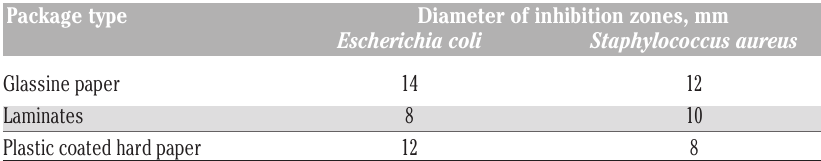
Table 3. Effectiveness of the bacteriocin coating on